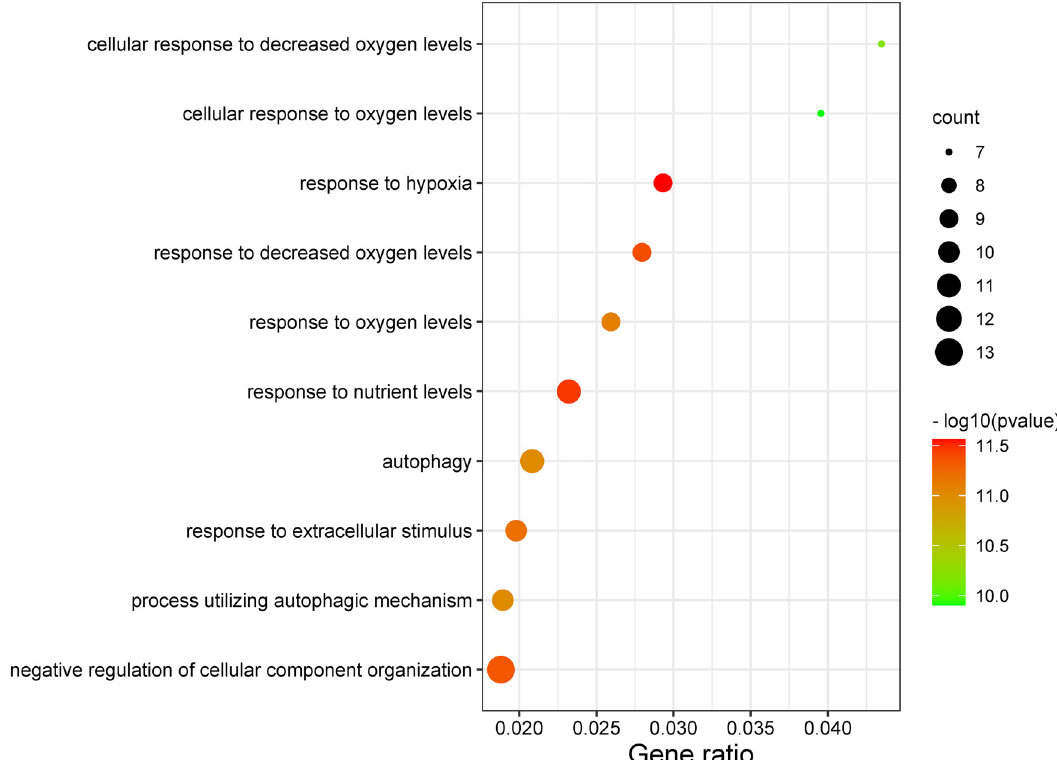
Figure 4: Bubble diagram of GO - BP enrichment analysis of